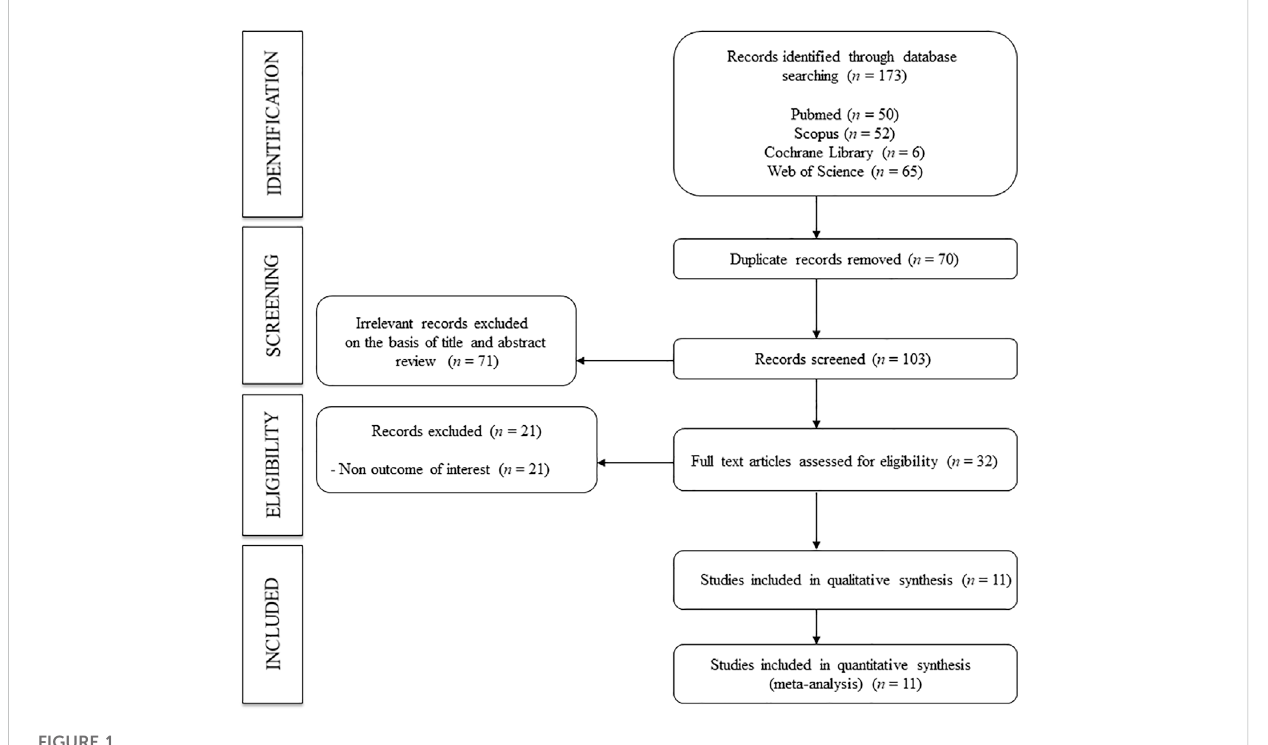
FIGURE 1 Flowchart: search